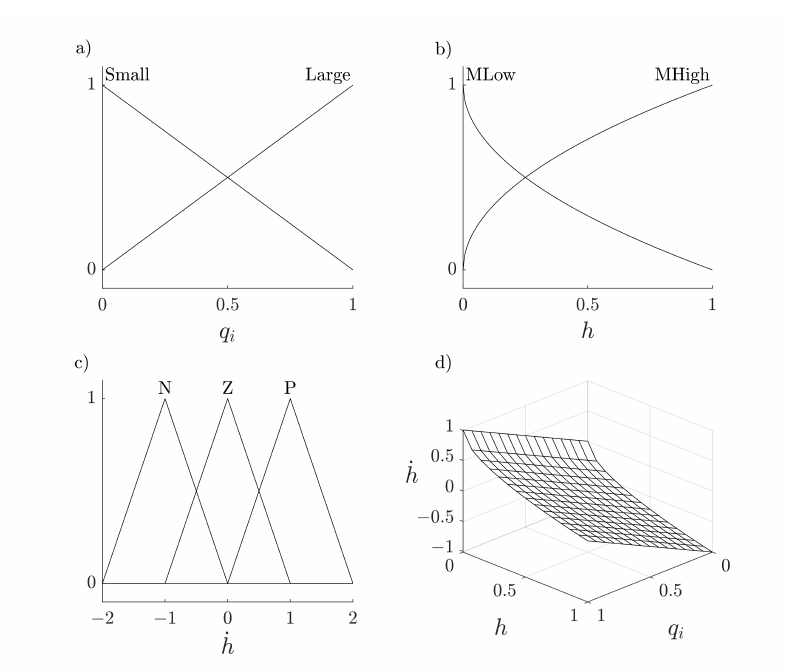
Figure 19. Dynamical evolution of the tank.